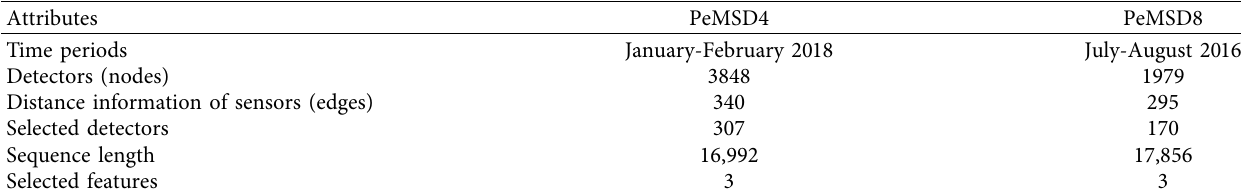
Figure 5: Example of time series segment input. Table 1: Dataset